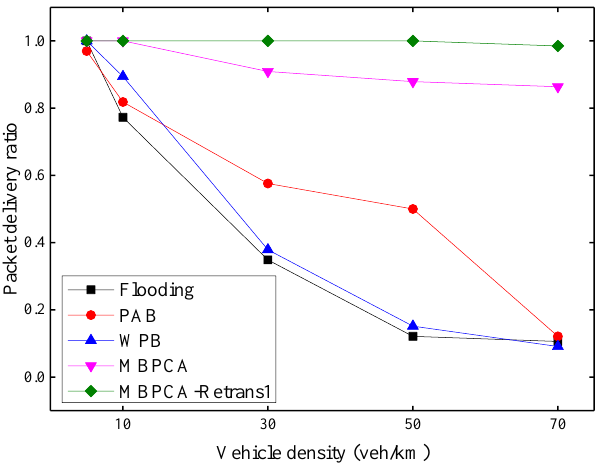
Figure 12. Packet delivery ratio under different vehicle densities.